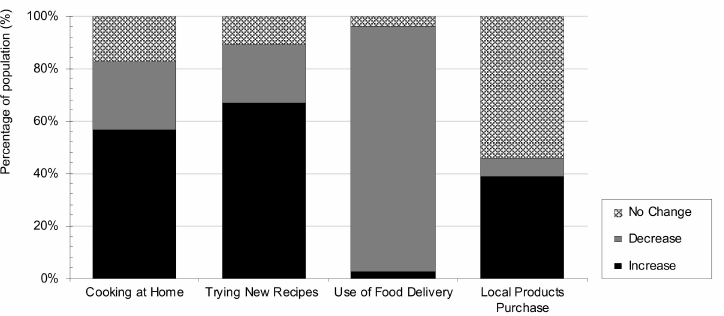
Figure 3. Percentage of population that reported changes in culinary behaviors during COVID-19